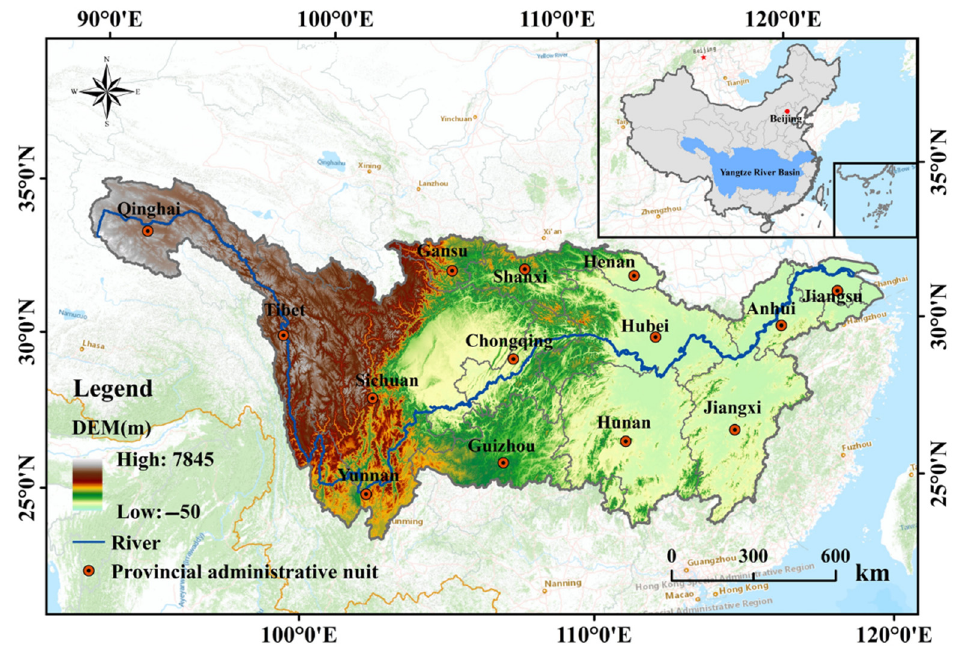
Figure 1. Location map of the Yangtze River basin.